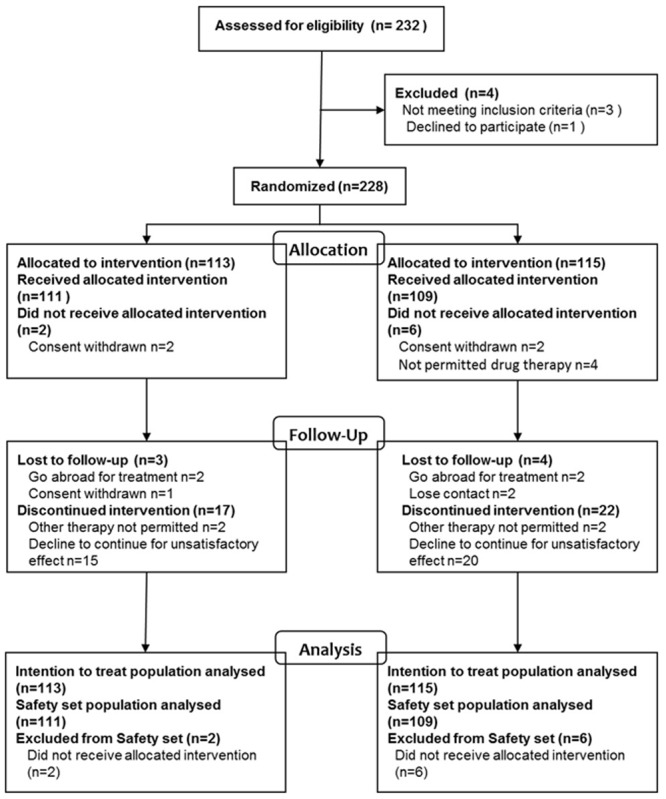
CONSORT diagram.